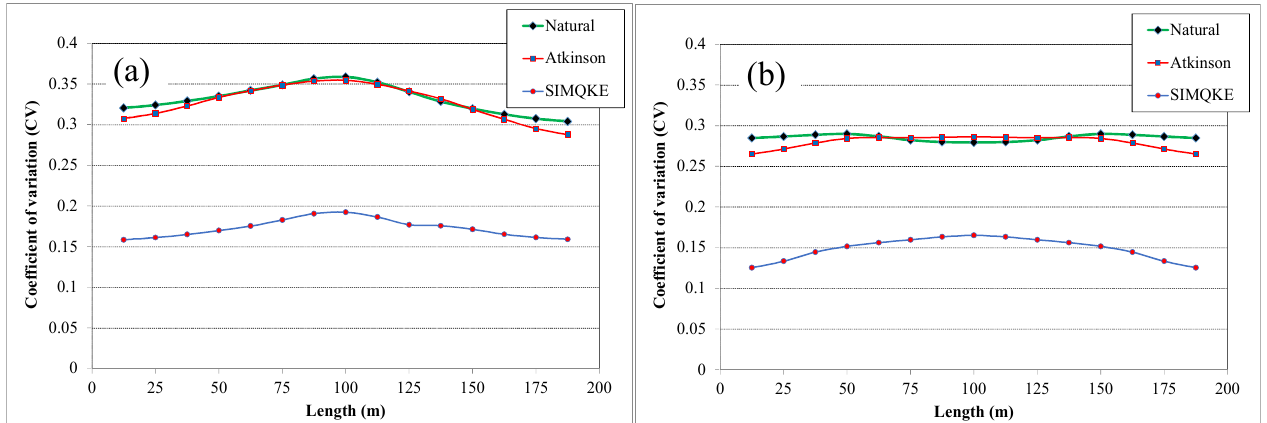
Figure 11. Coefficient of variation for predictions from different record types for ( a ) irregular bridge and ( b ) regular bridge.